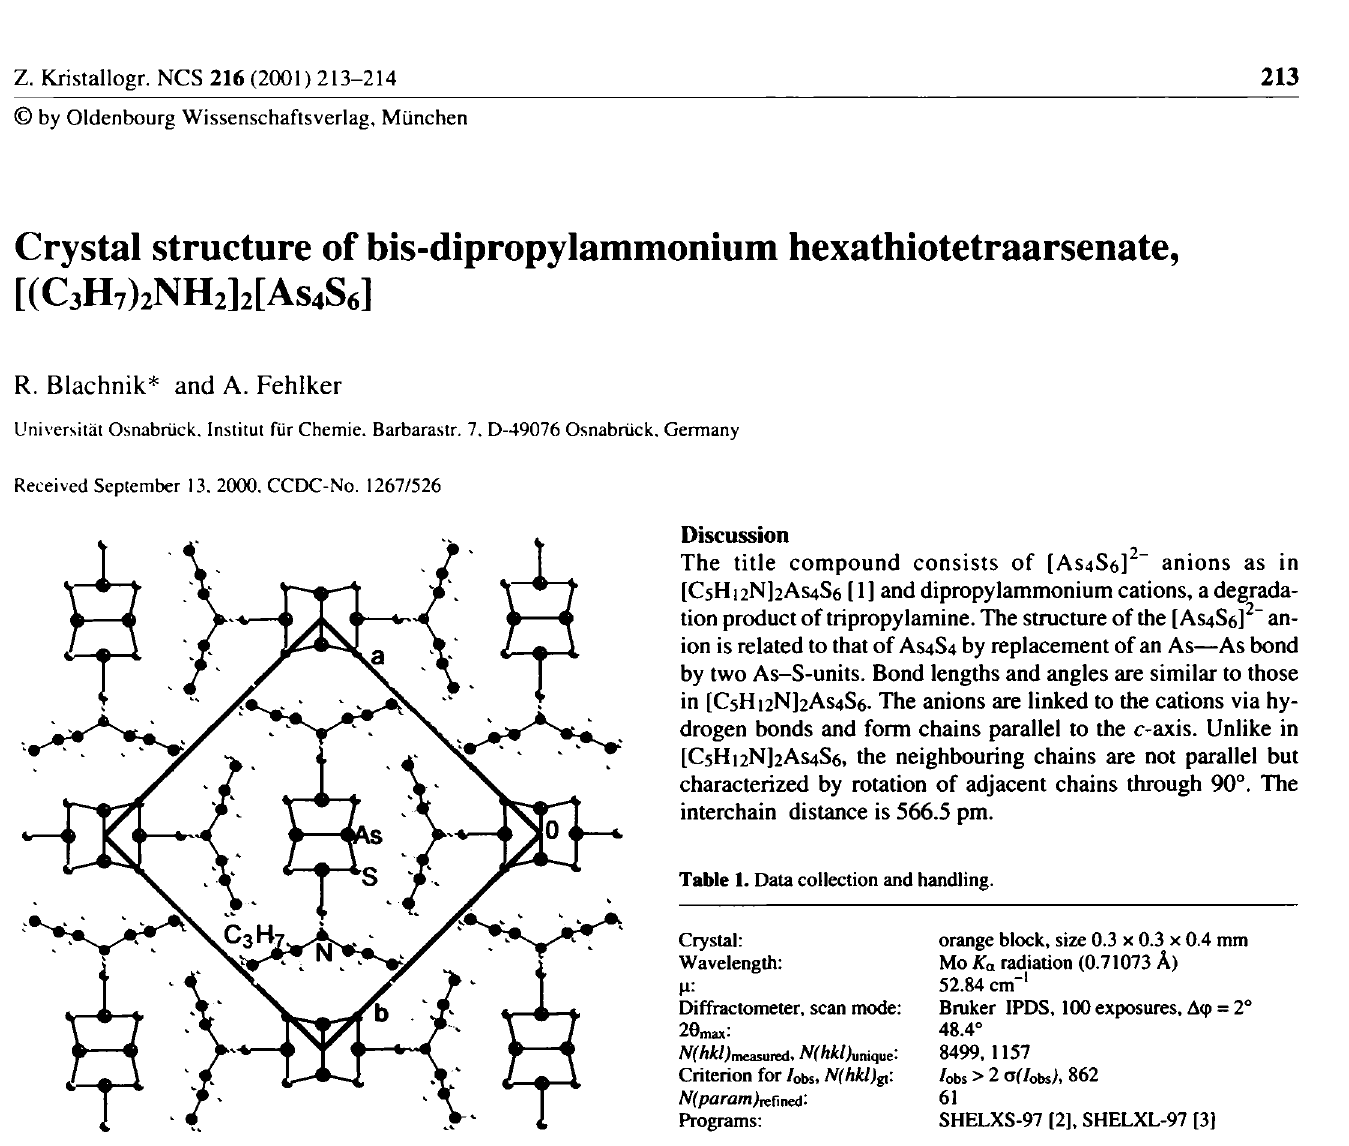
Table 2. Atomic coordinates and displacement parameters (in Ä 2